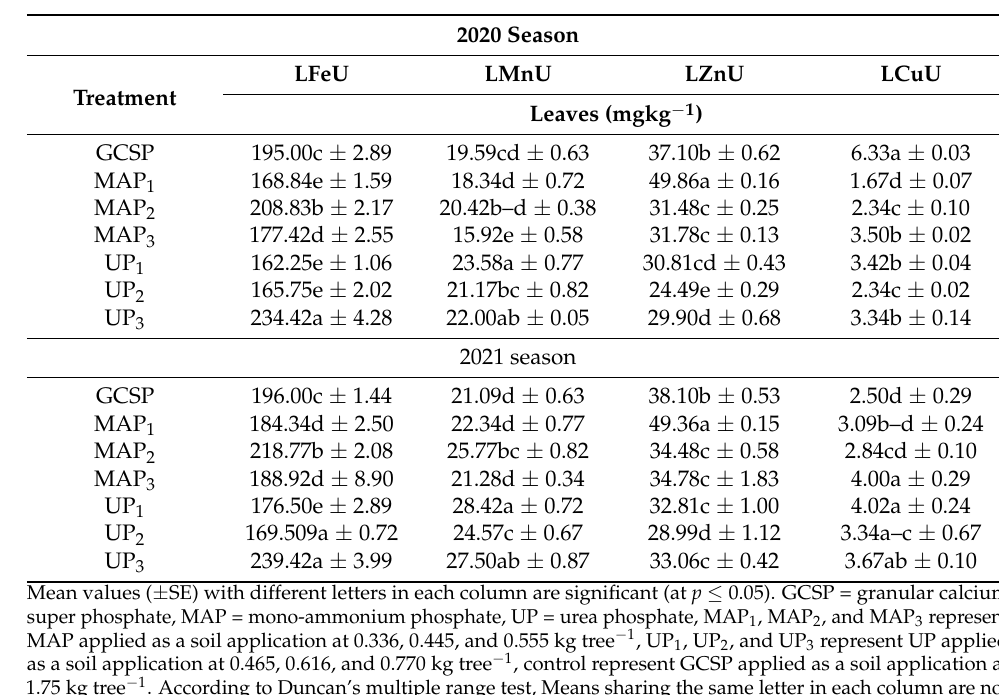
Table 6. Influence of different levels of MAP and UP in comparison with the recommended GCSP level on leaf micronutrient uptakes of olive ( Olea europaea L. arbequina cv.) trees grown in sandy loam clay soil under multi-abiotic stresses (CaCO 3 = 8.8 vs. 9.2%, ECe = 6.4 vs. 7.2 dS m − 1 , and pH = 7.78 vs. 7.89) during 2020 and 2021 seasons.